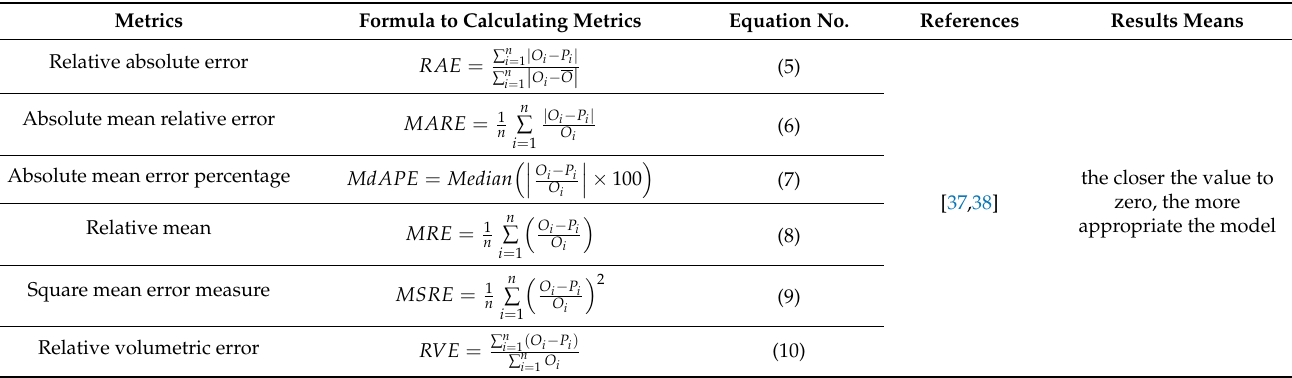
Table 1. Validation metrics for assessing the validity of the